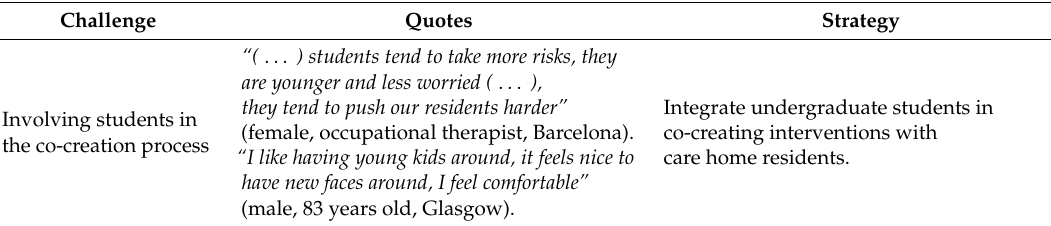
Table 3. Summary of the challenges to be faced, quotes and strategies